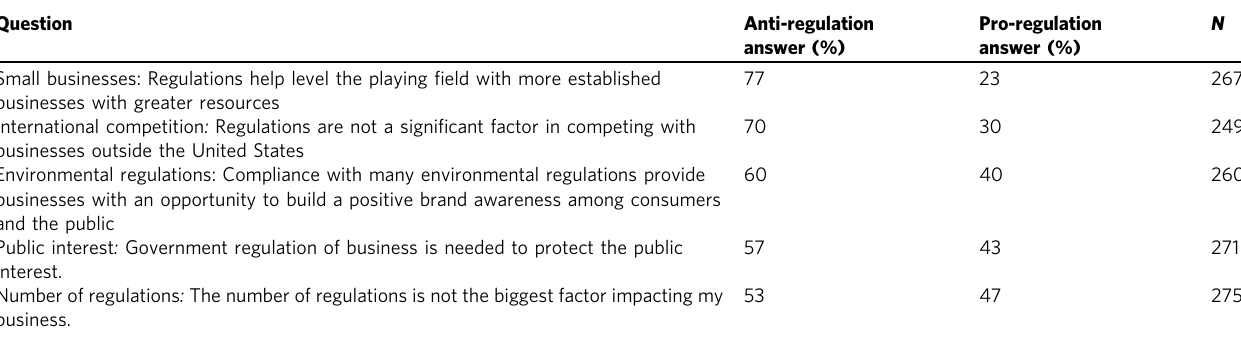
Table 2 Regulatory attitudinal questions.